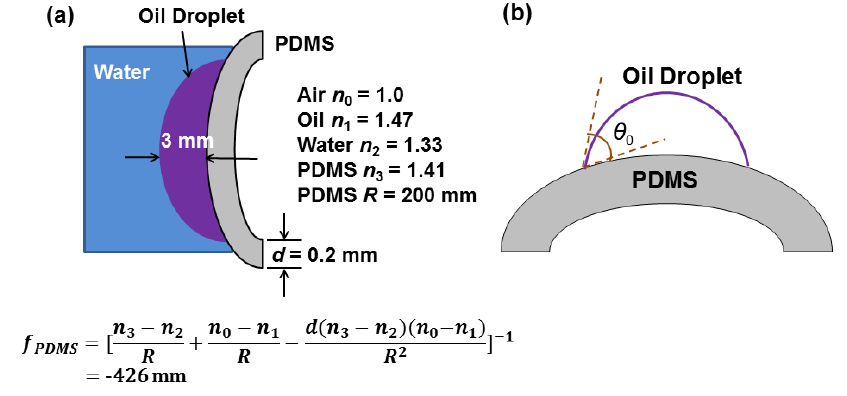
Figure 6. ( a ) Schematic of the overall optical system when the liquid lens is on a curved surface. The PDMS substrate forms a diverging lens and its focal length is around − 426 mm; ( b ) contact angle of an oil droplet on curved PDMS